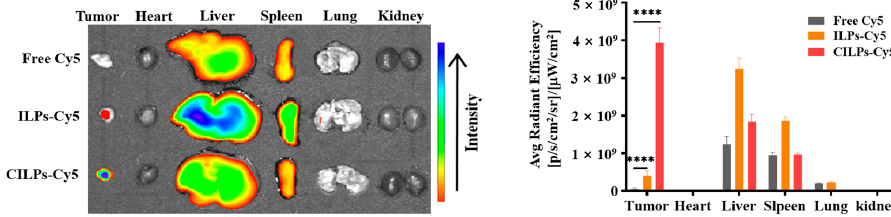
Figure 5. The distribution of Cy5-fluorescence in tumors and major organs at 24 h after intravenous administration. Data are shown as means ± standard deviation ( n = 3). **** p < 0.0001.